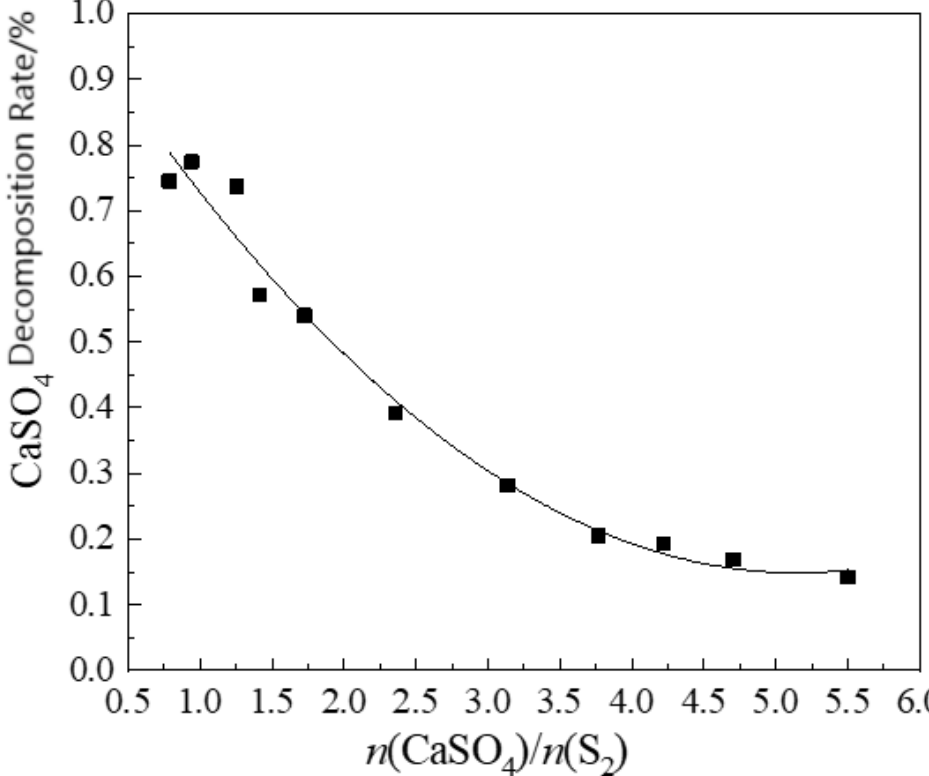
Figure 11. CaSO 4 decomposition rate curve under different n (CaSO 4 )/ n (S 2 ) conditions.